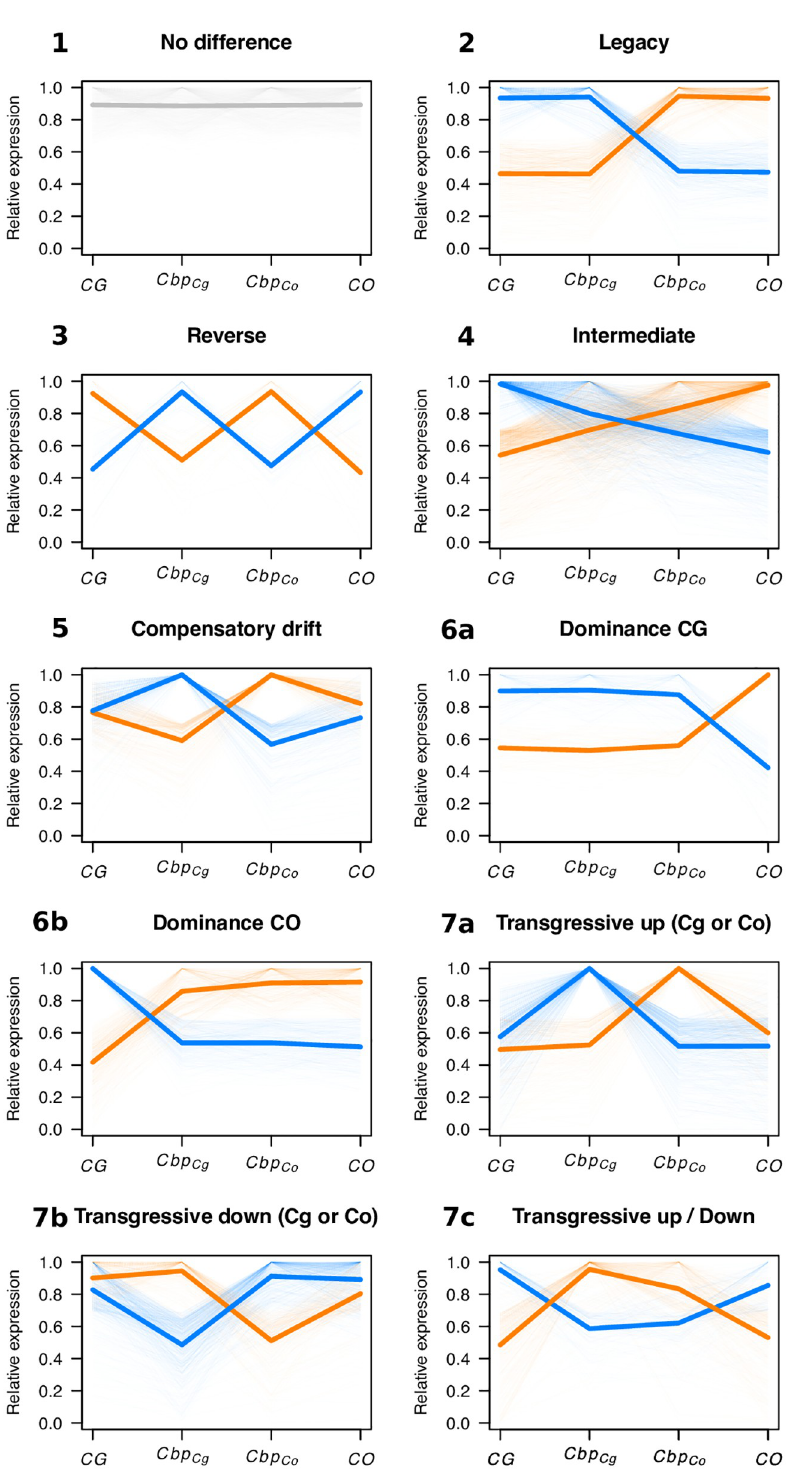
Fig 6. Main categories of expression variation of C. bursa-pastoris subgenomes relative to expression in parental species. The figure shows expression in flower as an example. Each transcript was assigned to one of seven main categories defined from the relative expression pattern of Cbp subgenomes ( Cbp ( CG and CO ). For each category, dashed lines correspond to single transcript relative expression to the maximal expression of this transcript in parental genomes or subgenomes. Solid lines indicate the average expression for each genome or subgenome. Colors discriminate alternative patterns in the same category.